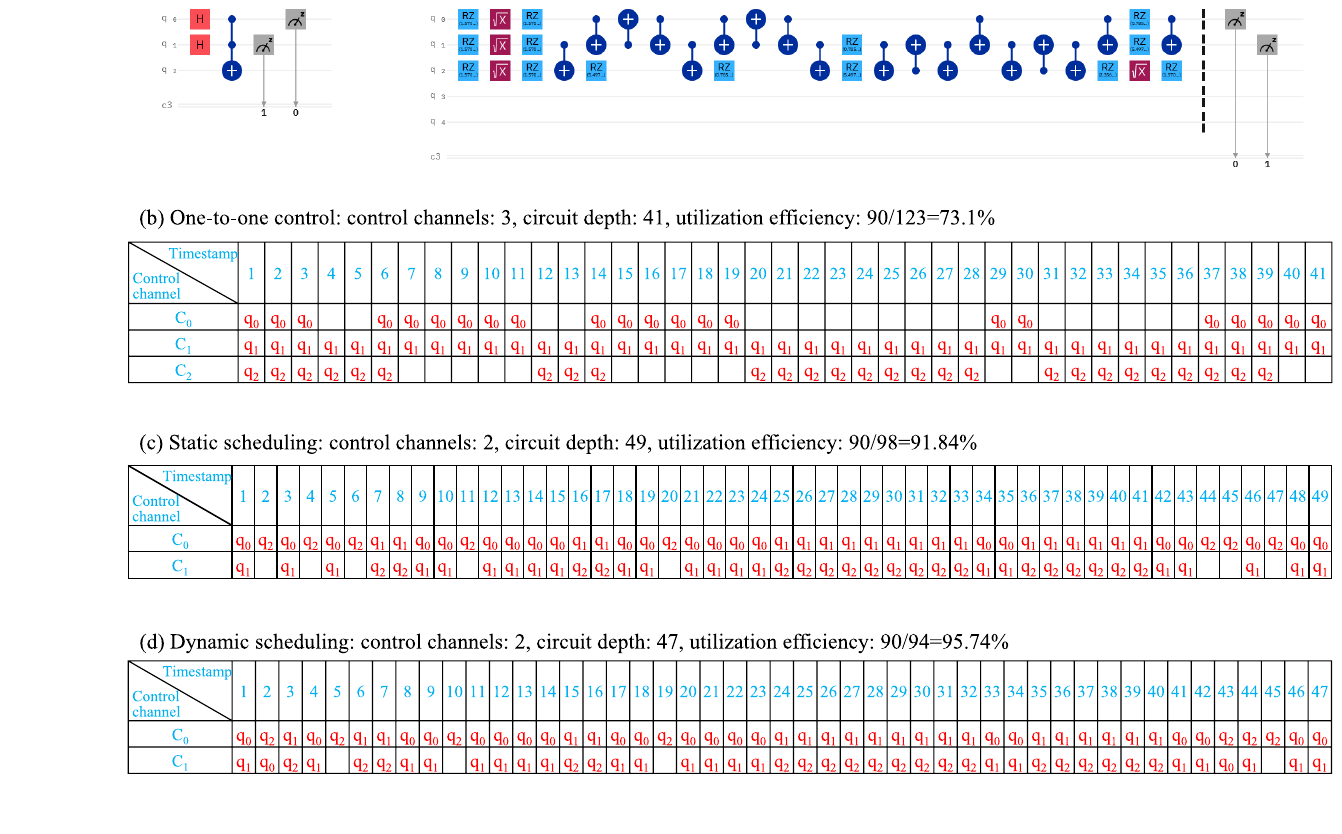
Figure 2. ( a ) The decomposed result of the original quantum circuit. ( b ) The scheduling sequence of traditional one-to-one control method. ( c,d ) The optimized results using static scheduling and dynamic scheduling,